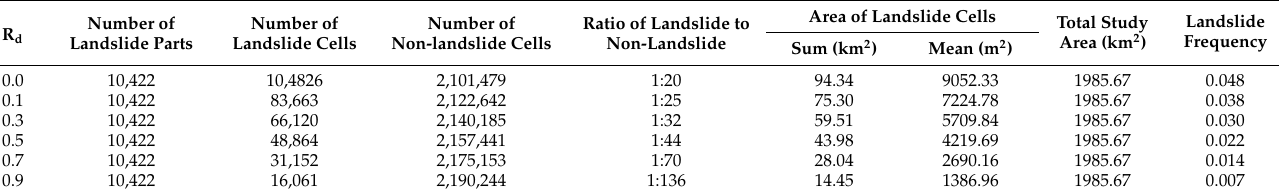
Table 3. Inventories of different landslide